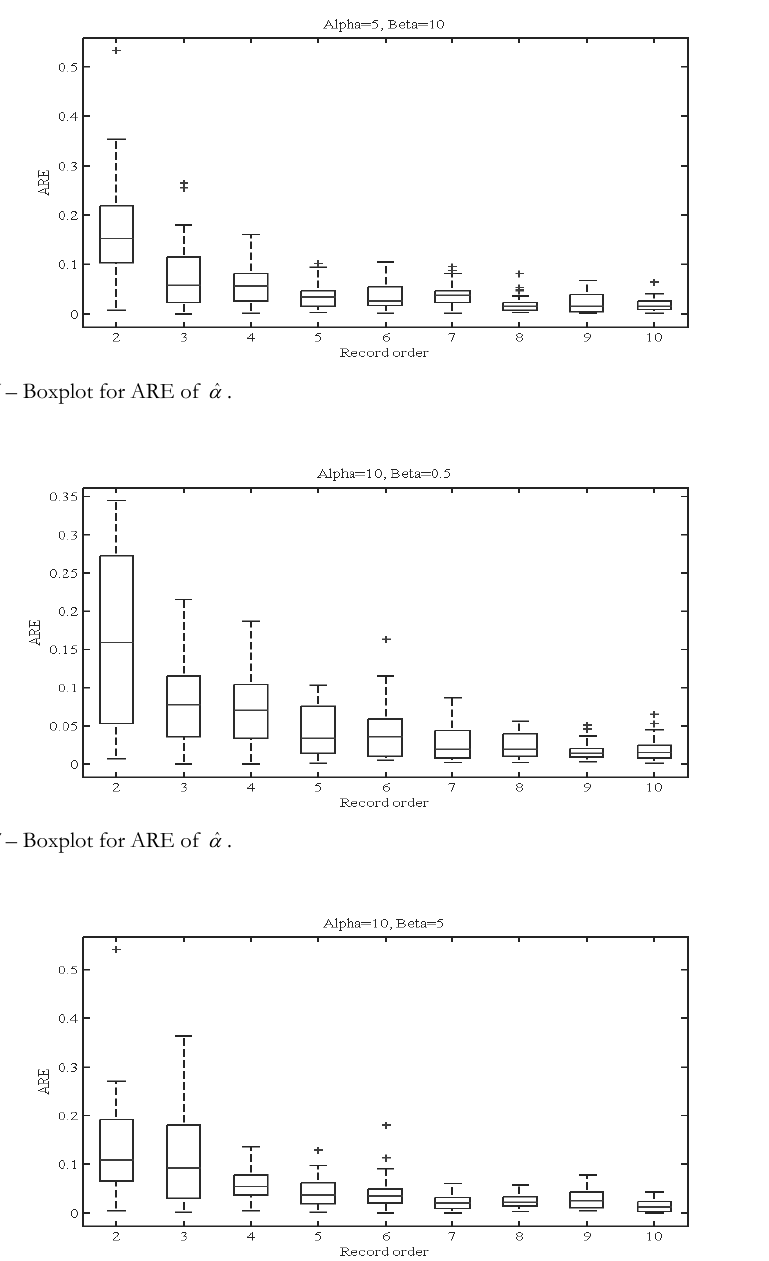
Figure 8 – Skewness coefficient of